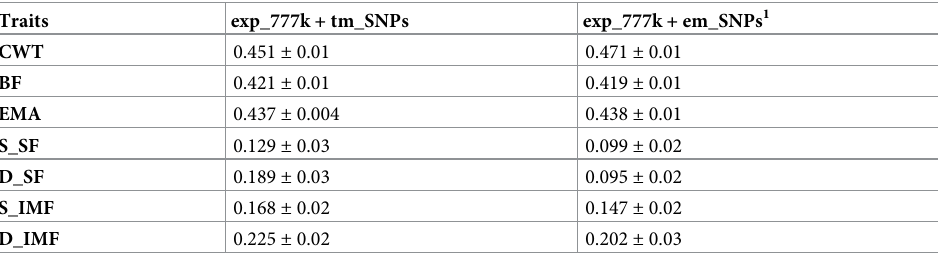
Table 6. Accuracy of evenly-mined GBLUP and text-mined